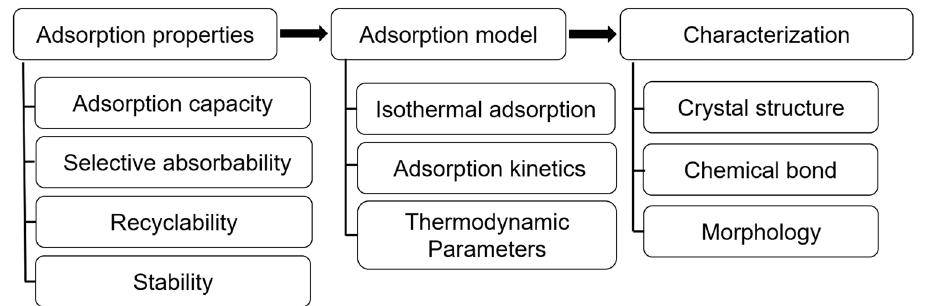
Figure 3: Schematic overview of LDH research